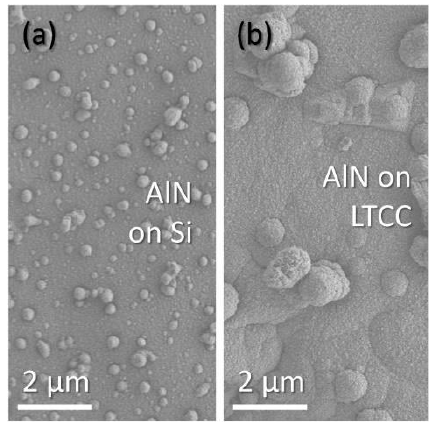
Figure 10. SEM micrographs of initial nuclei in #1: ( a ) silicon; ( b ) ceramic.